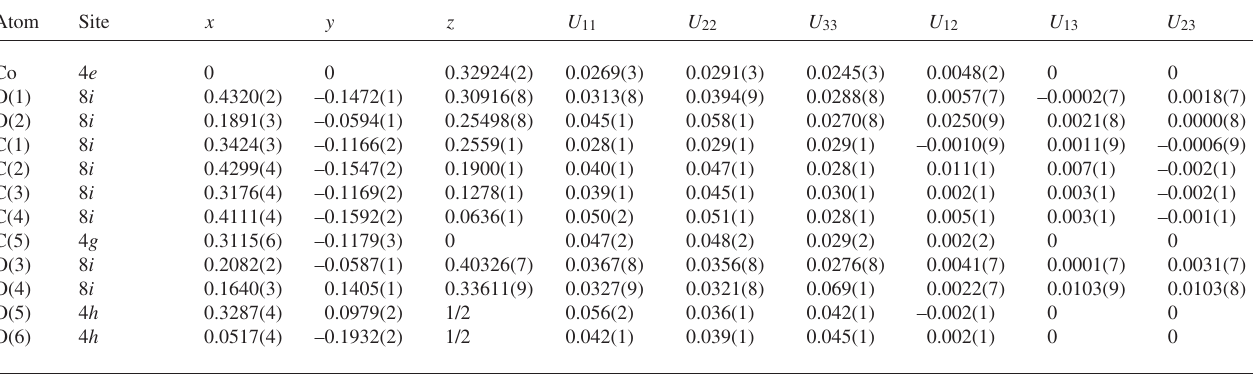
Table 3. Atomic coordinates and displacement parameters (in Å 2 ) .